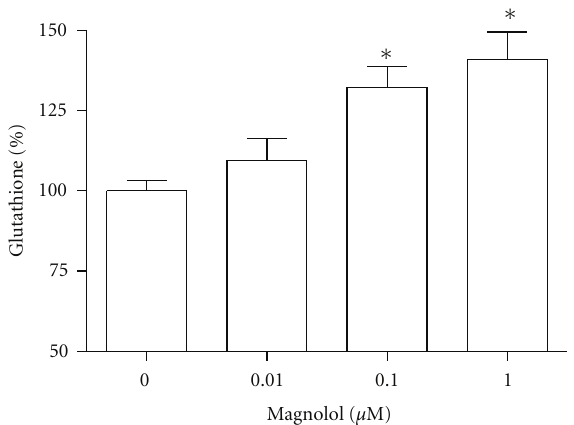
Figure 6: E ff ect of magnolol on antimycin A-induced RANKL pro- duction of MC3T3-E1 cells. E ff ect of magnolol on the production of RANKL in the presence of antimycin A. Osteoblasts were pre- incubated with magnolol before treatment with 70 μ M antimycin A for 48h. Data were expressed as a percentage of control. The control value for RANKL was 3.378 ± 0.074 ng/mg. ∗ P < 0 . 05, control versus antimycin A; # P < 0 . 05, antimycin A versus